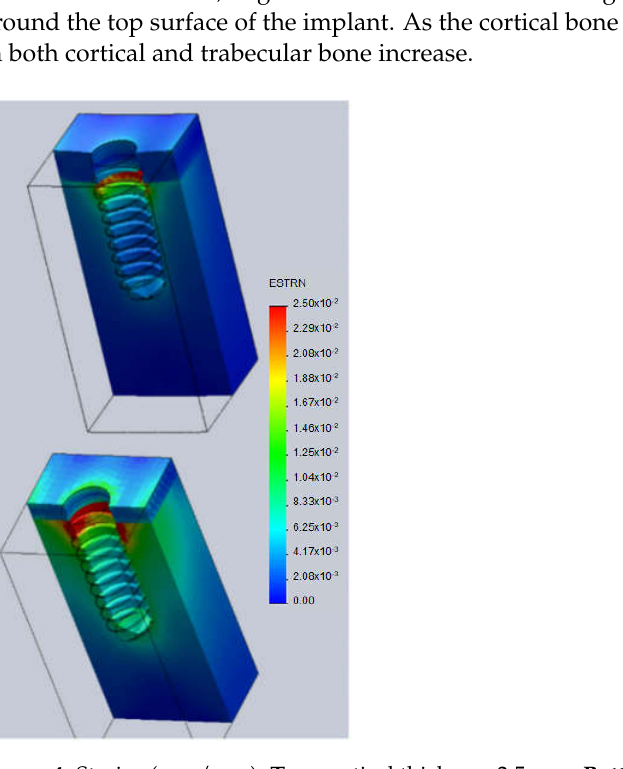
Figure 4. Strains (mm/mm). Top: cortical thickness 2.5 mm. Bottom: cortical thickness 1.5 mm.